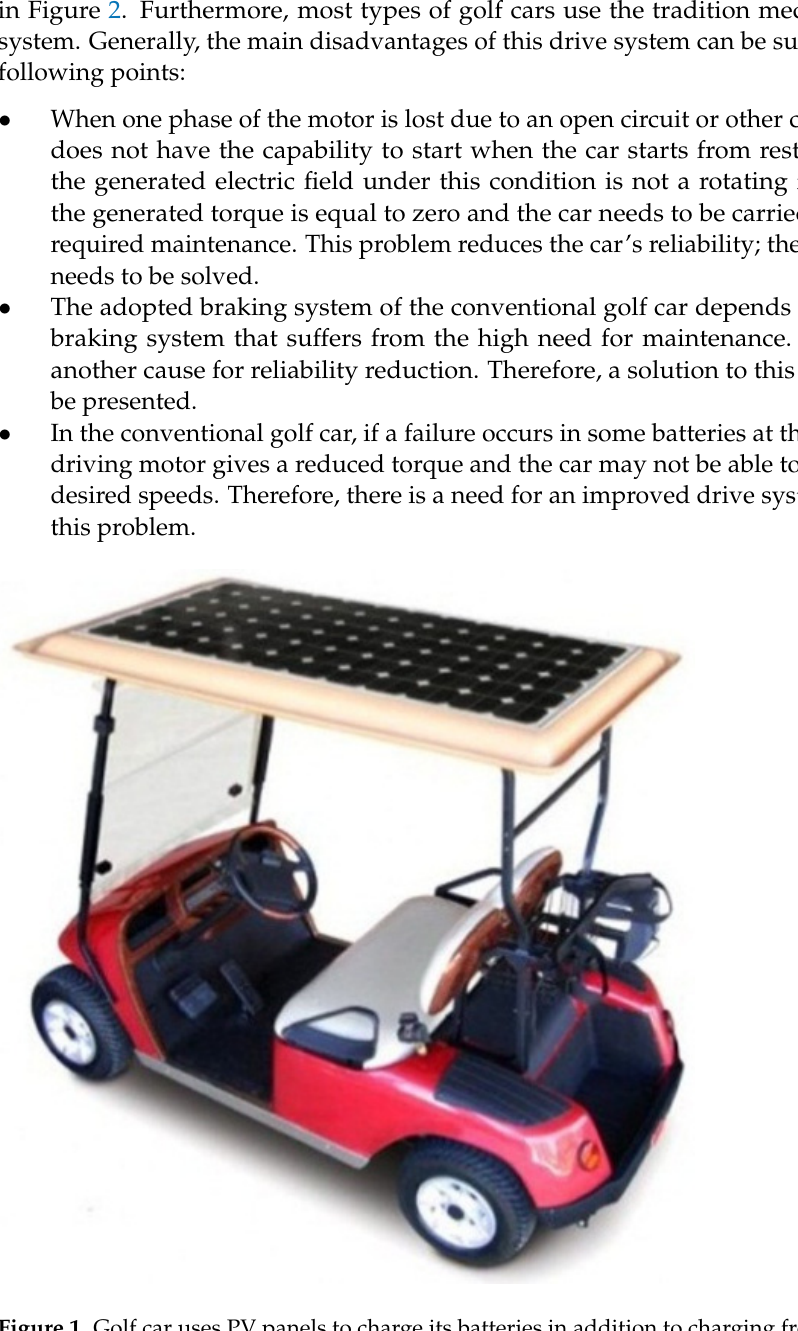
Figure 1. Golf car uses PV panels to charge its batteries in addition to charging from utility.